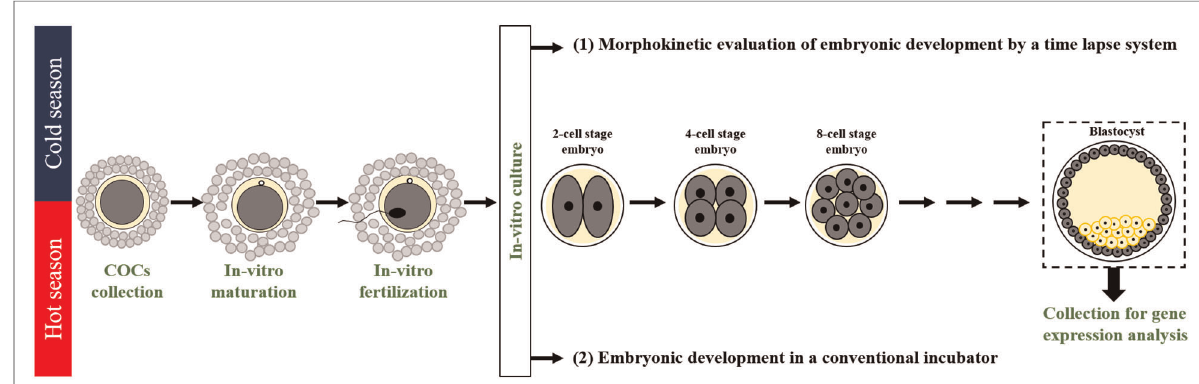
FIGURE 1 Experimental design . A seasonal study was performed in the cold and the hot seasons in the years 2018, 2019, and 2020. Cumulus-oocyte complexes (COCs) were aspirated from bovine ovaries collected at the slaughterhouse, in-vitro matured (22 h), and in-vitro fertilized (18 h). Then, putative zygotes were in-vitro -cultured: (1) individually for 190 h in an incubator equipped with a time-lapse system to allow non-invasive and continuous monitoring of the morphokinetic patterns throughout embryonic development. Morphokinetic monitoring included kinetic evaluation of the timing of the fi rst, second, and third divisions and of blastocyst formation; morphological evaluation of embryos (good, fair, and poor) throughout the fi rst, second and third divisions, as well as for the developed blastocysts; characterization of the fi rst cleavage pattern into Normal or abnormal groups, followed by a further classi fi cation into subgroups: synchronous and asynchronous within the Normal, and direct, unequal, and reverse within the abnormal. Samples of individual blastocysts were subjected to mRNA extraction for gene expression analysis performed by RT-qPCR. (2) An additional experiment was performed in a conventional incubator throughout the cold and hot seasons. COCs were in-vitro -matured and fertilized; 10 putative zygotes were grouped and incubated in a conventional incubator for 190 h of culture. The developed blastocysts were pooled and subjected to mRNA